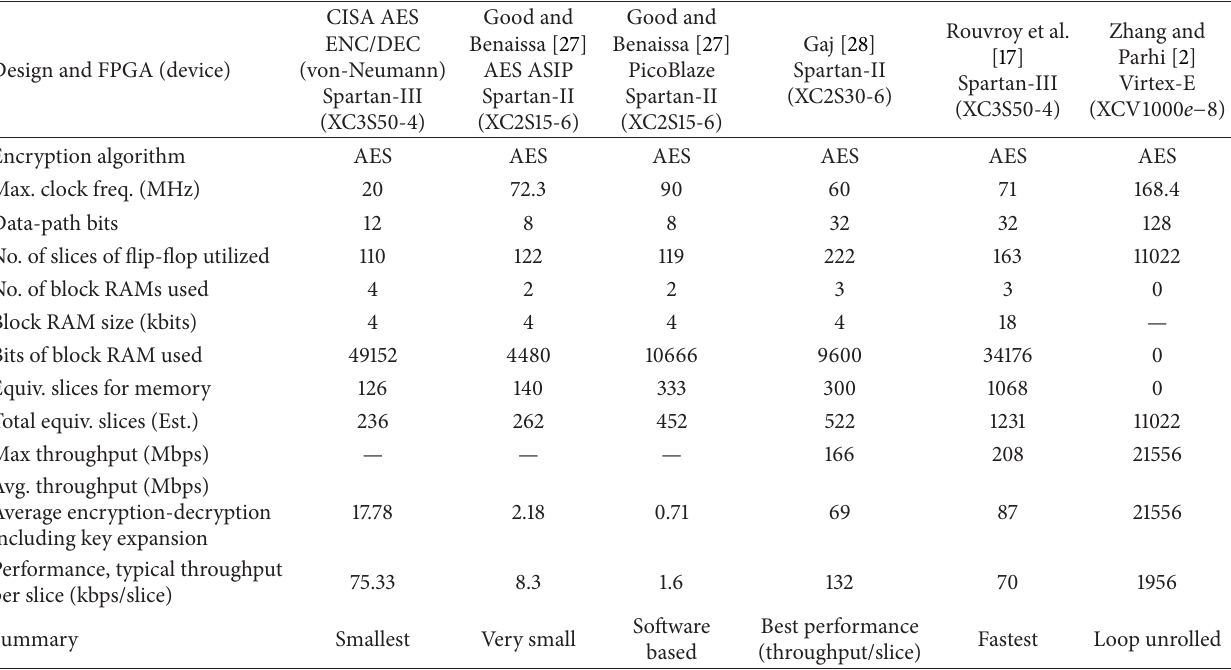
Table 8: Comparisons with other small AES processors.